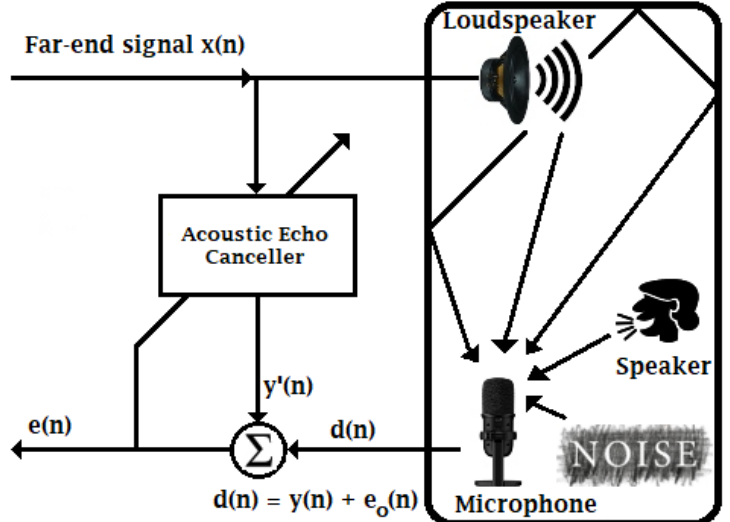
Figure 3. Structure of Acoustic Echo Canceller.